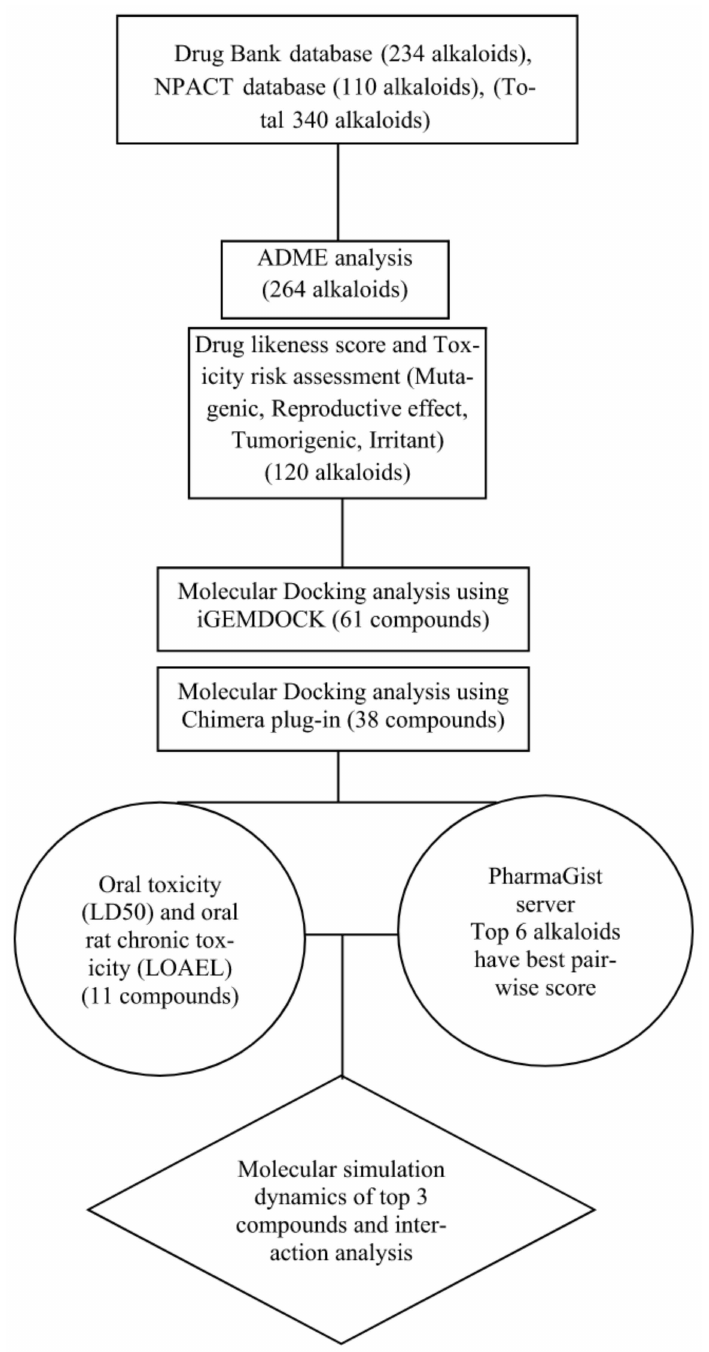
Figure 1. Schematic representation of the work flow adopted in the